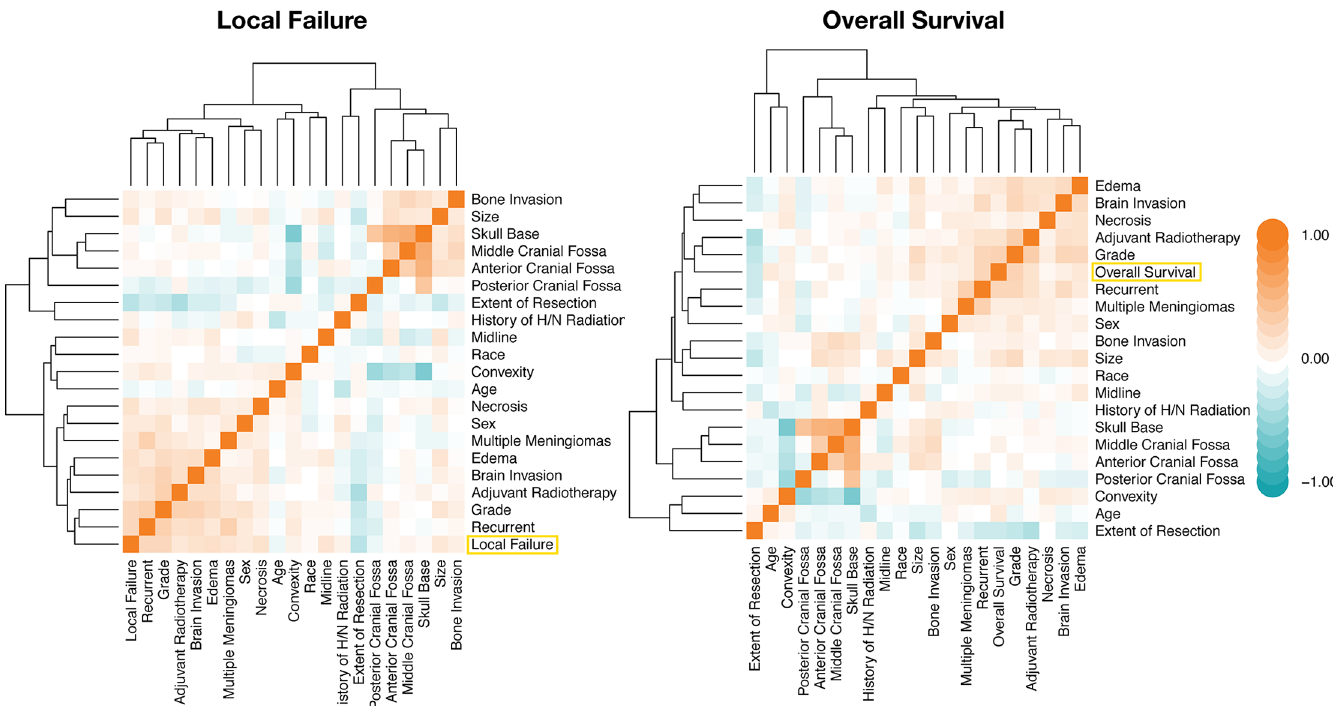
Fig 2. Meningioma feature correlation heatmaps. Heatmaps based on features’ pairwise Pearson correlation. Rows and columns have been arranged by hierarchical clustering to reveal each feature’s relationship to the outcome of interest. Orange denotes positive correlations, and teal indicates negative correlations.